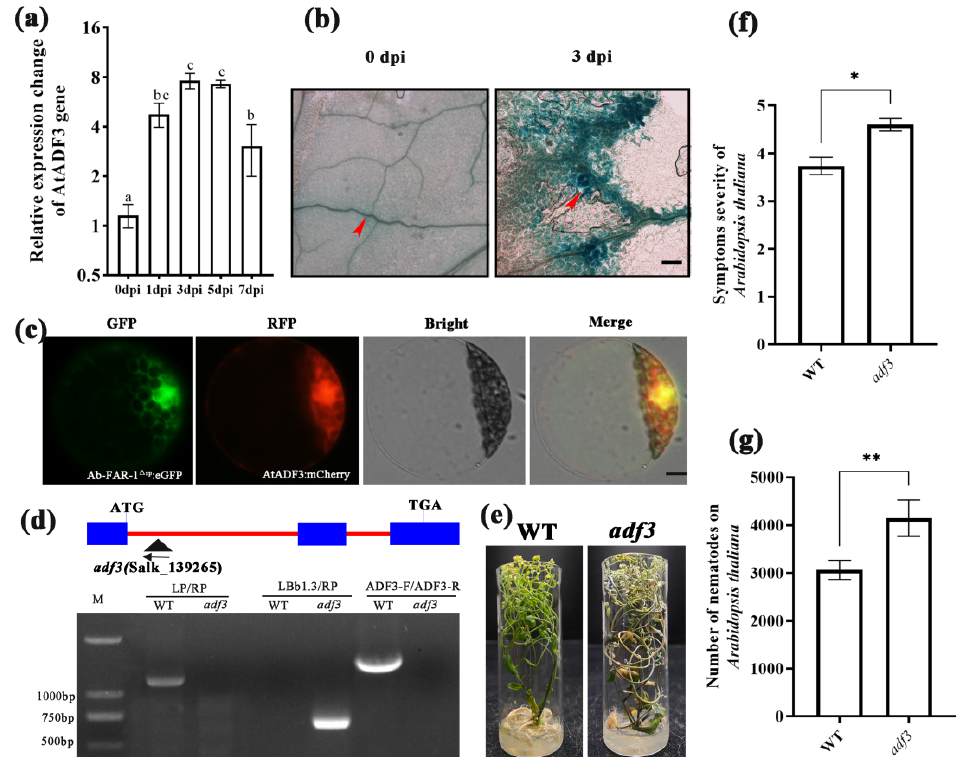
Figure 7. AtADF3 involved in the interaction between Aphelenchoides besseyi and Arabidopsis thaliana . ( a ) AtADF3 is upregulated in response to plant infection. Values are presented as the means ± SE, n = 9. ( b ) Histochemical staining for β -Glucuronidase (GUS) activity (blue colour) in nema- tode-infected leaves of an ADF3pro: GUS plant in which GUS expression is driven from the AtADF3 promoter. A stronger GUS signal was detected in the veins of the nematode-infected leaves than in healthy leaves. The red arrow indicates the location of the GUS signal. Bar = 200 μ m. ( c ) Subcellular localization of AtADF3 in protoplast cells of A. thaliana . Bar = 10 μ m. Different letters above bars denote values that are significantly different from each other ( p ≤ 0.05, Tukey’s test). ( d ) A. thaliana lines carrying T-DNA insertion at the AtADF3 locus. Diagrammatic representation of the genomic structures of AtADF3 indicating the location of T-DNA insertions in adf3 mutant (Salk_139265) lines relative to the translation start (ATG) and stop (TGA) codon. Exons are repre- sented as blue boxes and introns as red lines. The direction of the T-DNA sequence is indicated by black arrow. ( e , f ) The symptom severity was determined in the adf3 mutant. ( g ) The number of nematodes in the adf3 mutant. The number of nematodes was determined after inoculation of 100 adult nematodes on each plant (including culture medium) at 21 days post inoculation. Values are presented as the means ± SE ( n = 15). There were three independent biological replicates. Asterisks denote significant differences (* p < 0.05, ** p < 0.01; t -test).